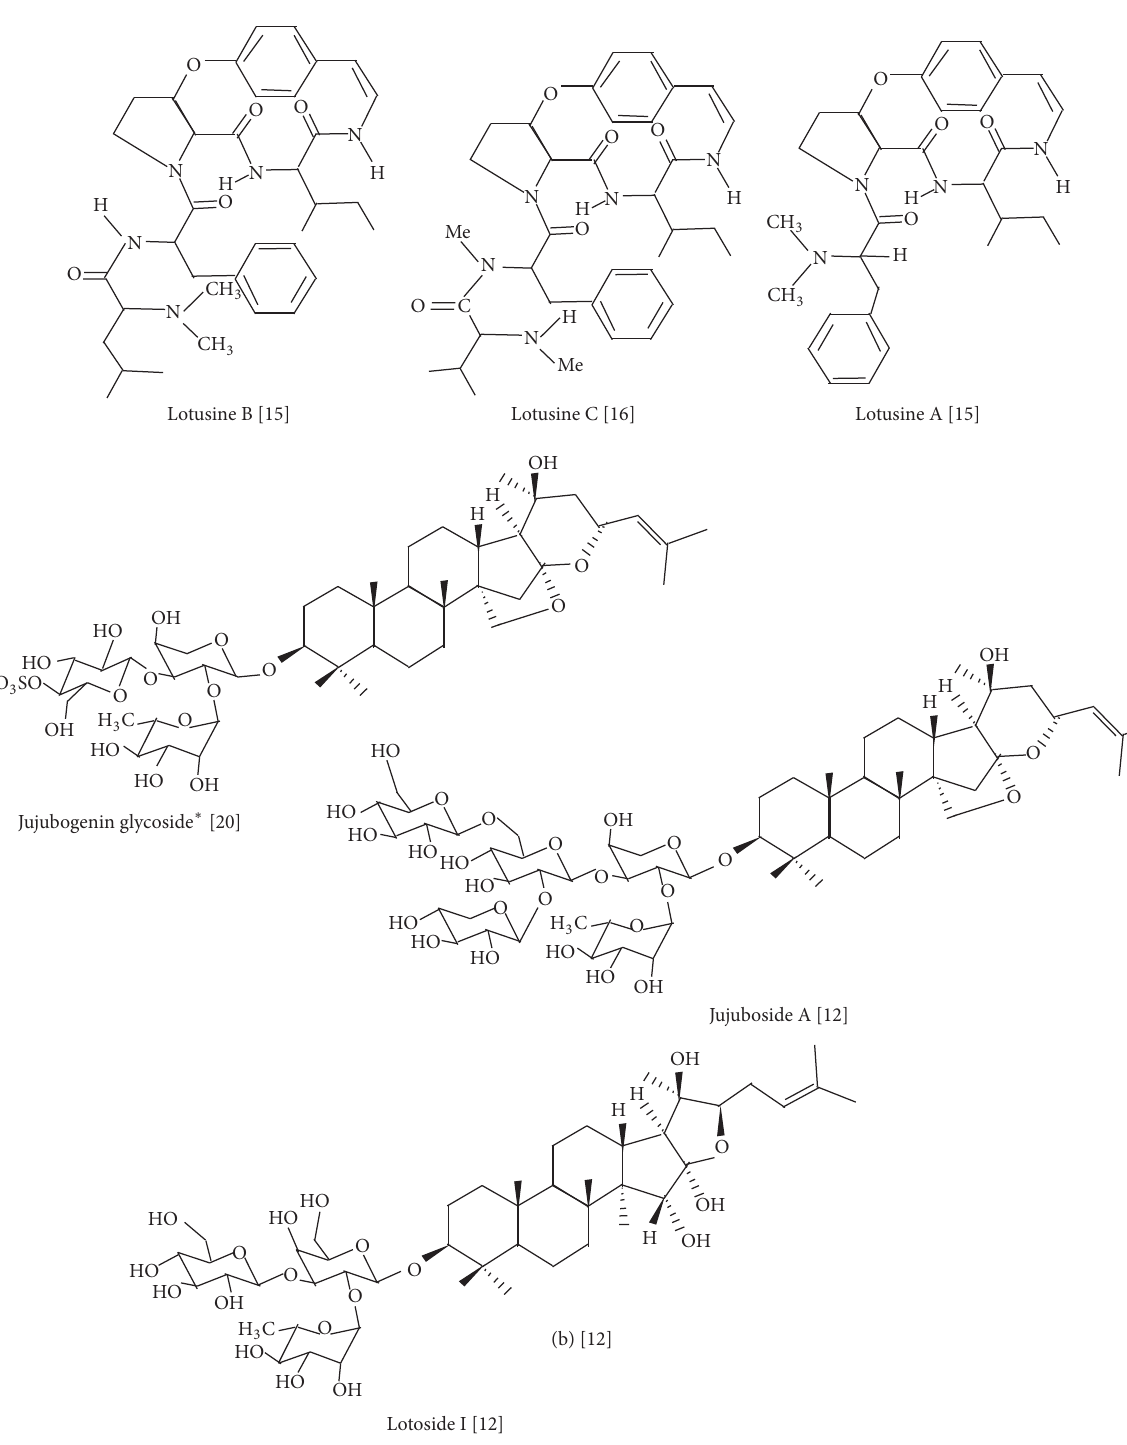
Figure 2: Structure of Z. lotus main phytoconstituents. Note: ∗ 3 -O- 𝛼 -L-rhamnopyranosyl-(1-2)-[(4-sulfo)- 𝛽 -Dglucopyranosyl-(1-3)]- 𝛼 -L-